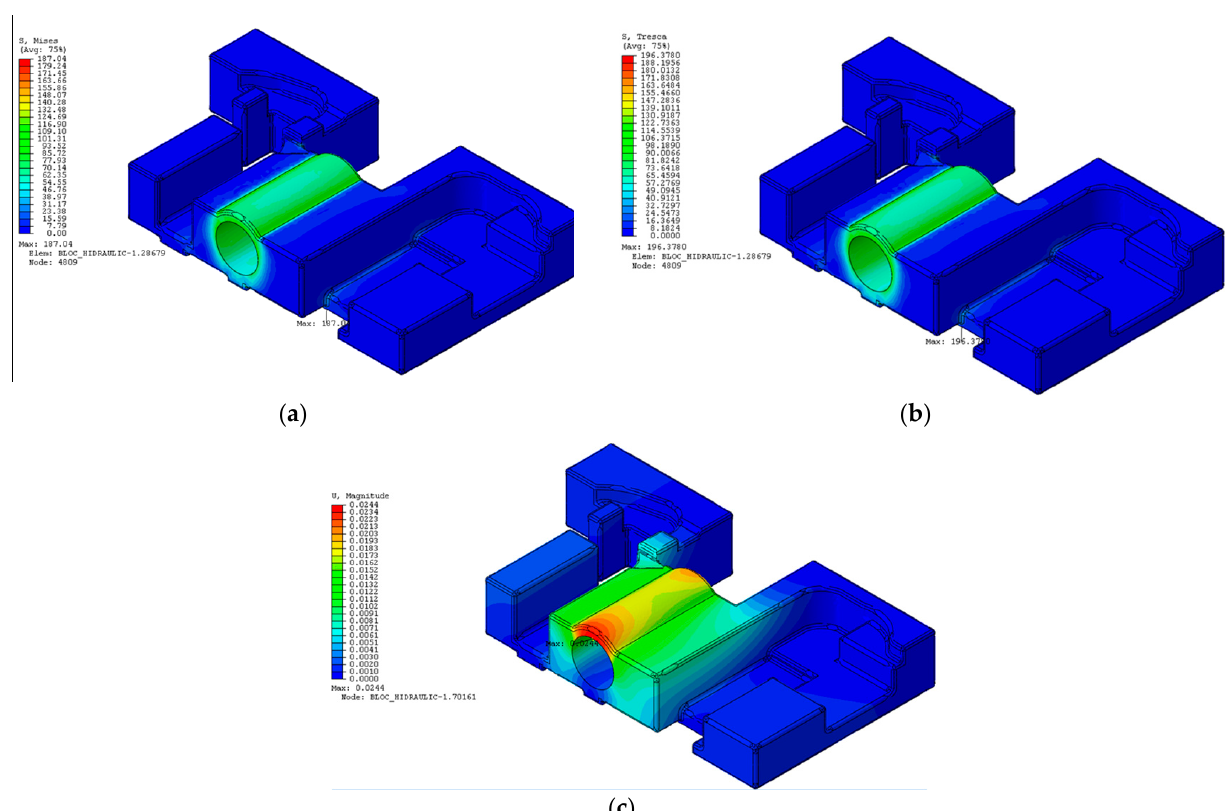
Figure 18. Results of the finite element analysis: ( a ) von Mises equivalent stress distribution; ( b ) Tresca equivalent stress distribution; ( c ) deformation distribution.